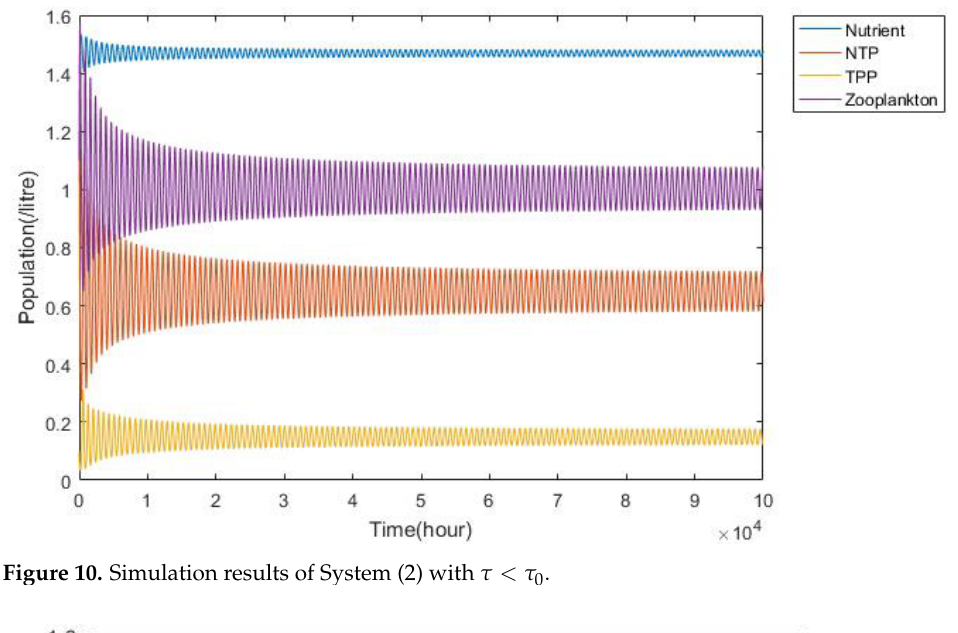
Figure 10. Simulation results of System (2) with τ < τ 0 .